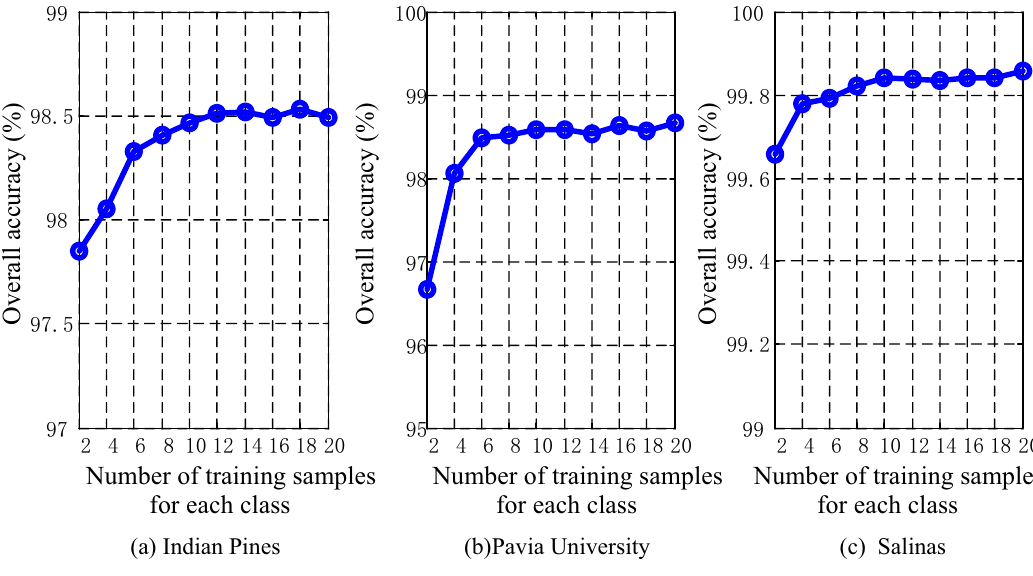
Figure 7. OA with SVM classifier versus the variation of the number of training samples for each